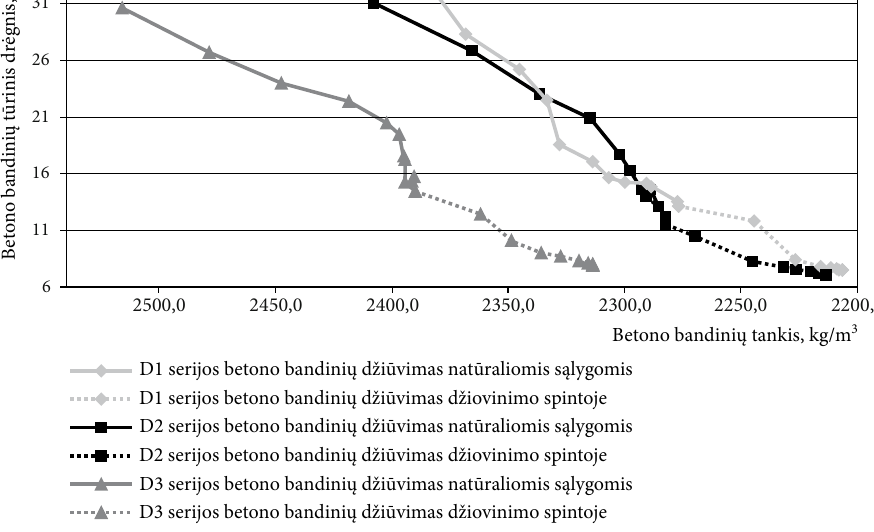
Betono bandinių tankis, kg/m